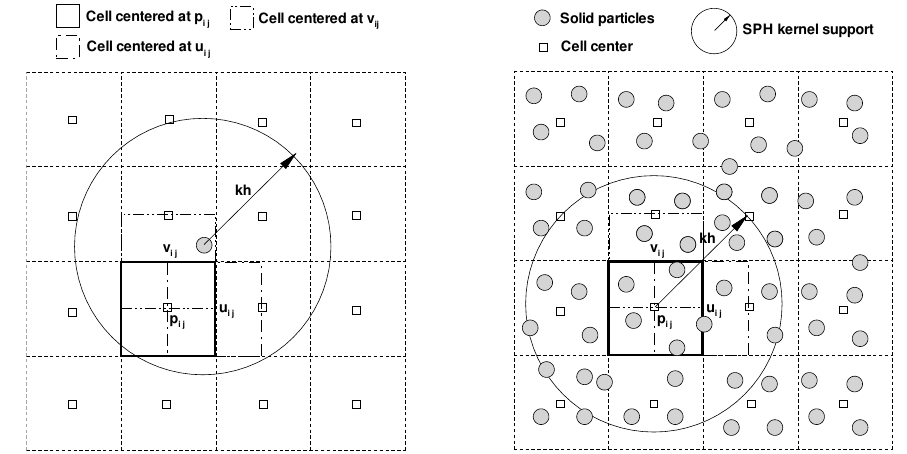
Figure 2. Interpolation strategy between Eulerian grid nodes and Lagrangian particles. Staggered grid for the Eulerian variables is illustrated. Left : Grid information transfer to a certain particle; Right : Transfer of particles information to the grid nodes. A square-type cell system (same ∆ x , ∆ y sides) is used here. kh is the radius of the support domain of a solid particle or a grid node, h is the initial distance between solid particles and k is a constant normally in the range from 2 to 4. A larger value of k implies more particles in the support